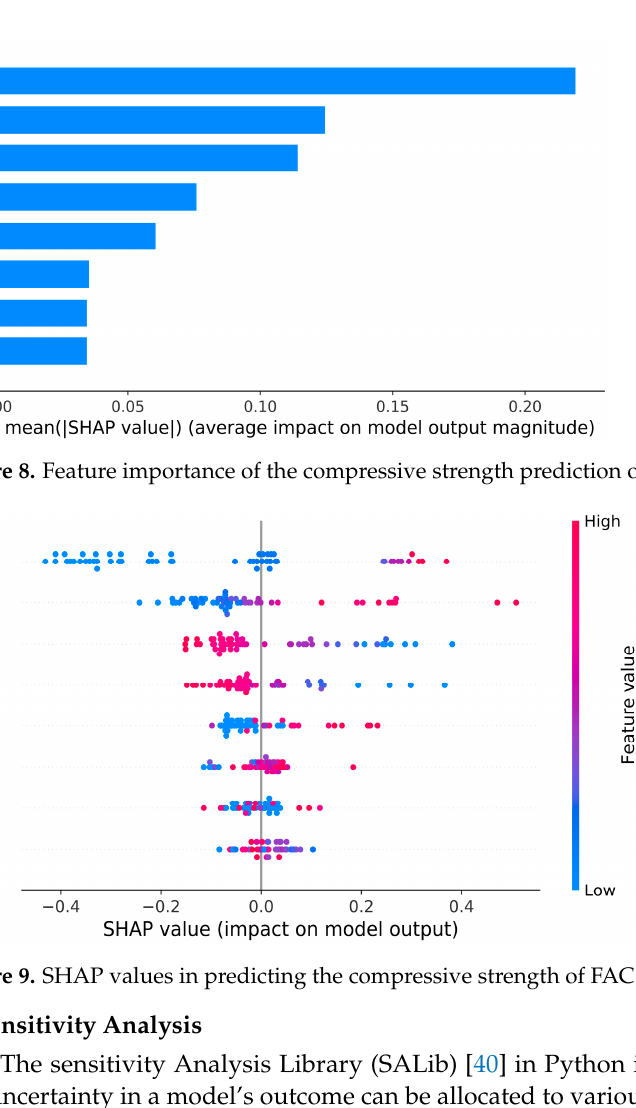
Figure 11. Sensitivity indices—first-order index. 7. Future Studies The SSE-RandomForest algorithm can be used to predict the compressive strength of FAC without using too many experimental works. This study does, however, have some limitations that should be explored and addressed in future studies. Other ML algorithms should be employed to compare their accuracy in predicting outcomes. It is also suggested that the results of the durability issue for FAC be factored into the models’ execution. To compare the outcomes of different methods, it is also proposed that the use of ML algo- rithms be examined for FACs cured with different kinds of curing methods, such as heat curing, lime curing, and steam curing, among others. Furthermore, the dataset’s range is slightly limited. Hence, experiments, field testing, and other numerical studies using var- ious methodologies should be used in future study to enhance data points. Despite several limitations, the findings of this study show that the method has a lot of potential in fore- casting the performance of FACs. It could be a valuable tool for designing the mix pro- portion of FACs. 8. Conclusions FACs replace standard Portland cement with industrial or agricultural by-product ashes as the principal binder; as a result, FAC is an eco-efficient and ecologically beneficial construction product. Compressive strength (CS) is the most significant mechanical attrib- ute for all types of concrete. However, in the realm of design/construction, the CS of con- crete at 28 days is critical. As a result, in order to save time, energy, and money, an au- thoritative model for forecasting the CS of the concrete is required. The objective of this study was to explore how ensemble learner (i.e., ML) techniques may be implemented to estimate the CS of FAC. Super learner, simple averaging, weighted averaging, integrated stacking, and separate stacking ensemble models were employed to predict the CS of FAC. The following are some of the inferences that can be drawn: